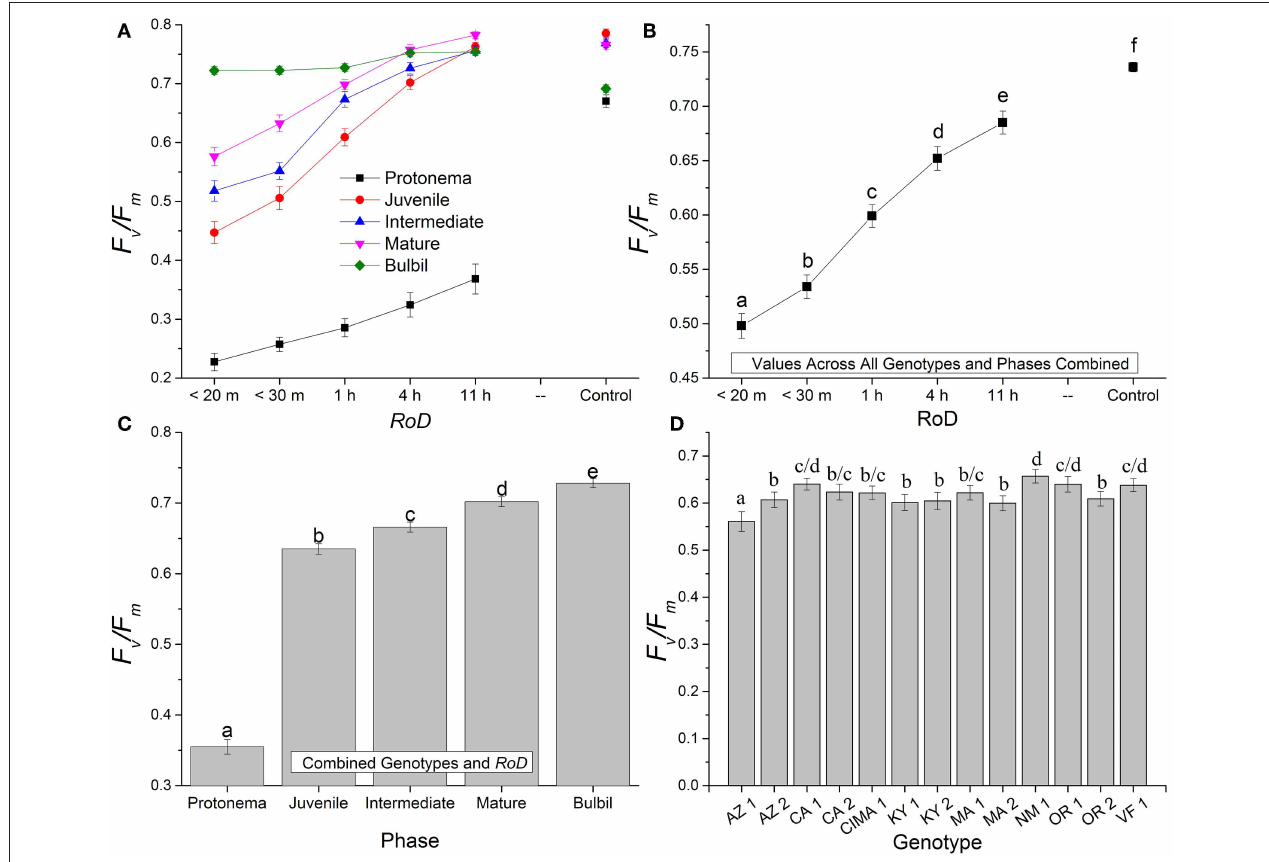
FIGURE 1 | Bryum argenteum F v /F m response variables. Panel of images showing Bryum argenteum F v / F m response variables 24h post rehydration for the treatment combinations indicated, error bars represent ± 1 SE, and lowercase letters represent homogeneous subsets established at an α of 0.05. (A) Two-way interaction between rate of drying (RoD) and life phase ( n = 65), (B) Main effect of RoD among life phase and ecotypes combined ( n = 390), (C) Main effect of life history phase among RoD and ecotype ( n = 390), (D) The effect of ecotype with all life phases and RoD treatments combined ( n = 150). RoD, Rate of